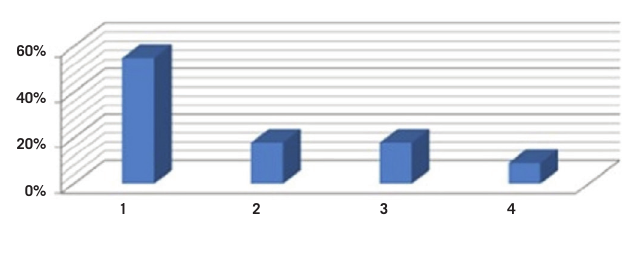
figurE 2 − NFGNB genera isolated from blood cultures analysis NFGNB: non-fermenting Gram-negative bacilli. 1. Acinetobacter sp.; 2. Pseudomonas sp.; 3. Stenotrophomonas sp.; 4. Burkholderia sp.